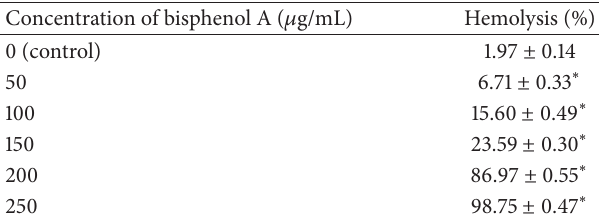
Table 2: Bisphenol A induced hemolysis.